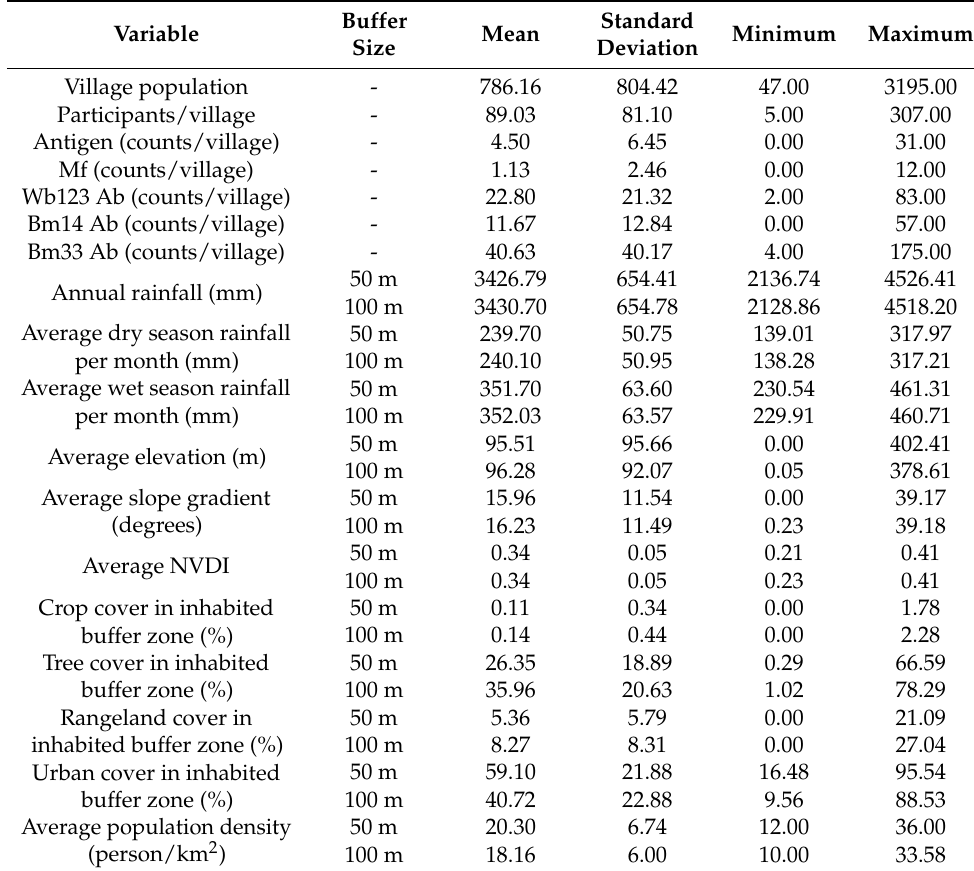
Table 3. Descriptive statistics for rainfall (mm), elevation (m), slope gradient (degrees), normalised difference vegetation index (NDVI), landcover class (percent of inhabited buffer zone covered), population density (persons/km 2 ) and counts of infection markers in a 2016 community survey, American